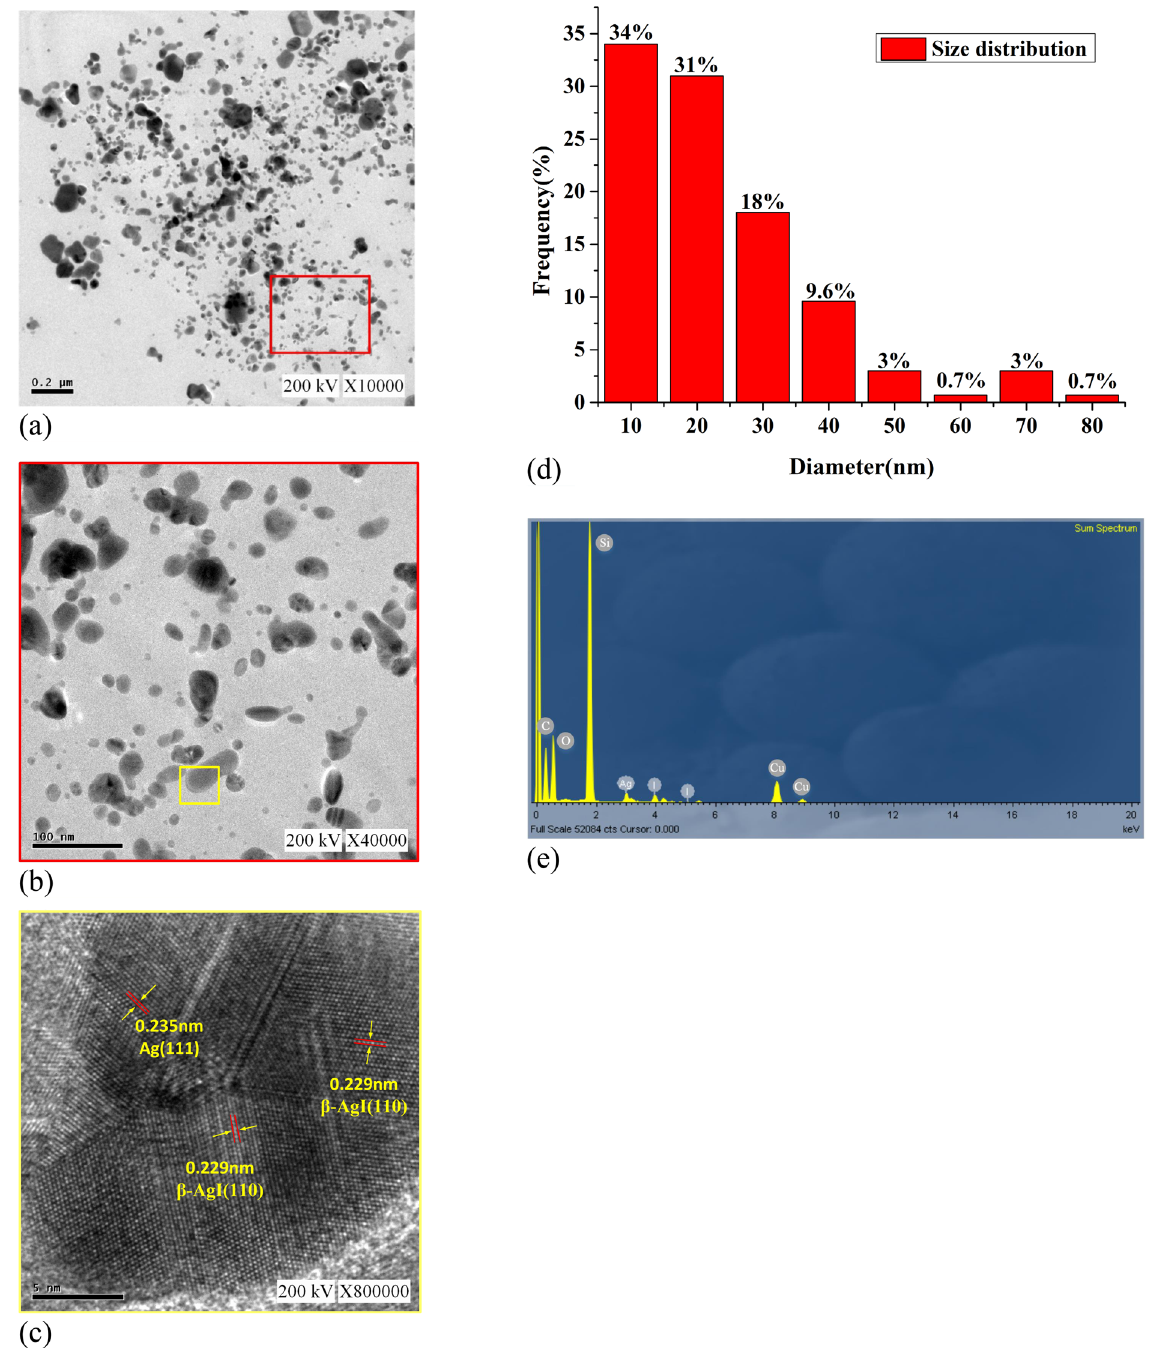
Figure 7. TEM analysis results at ( a ) 0.2 µm, ( b ) 100 nm, ( c ) 5 nm, ( d ) size distribution, and ( e ) EDS analysis.